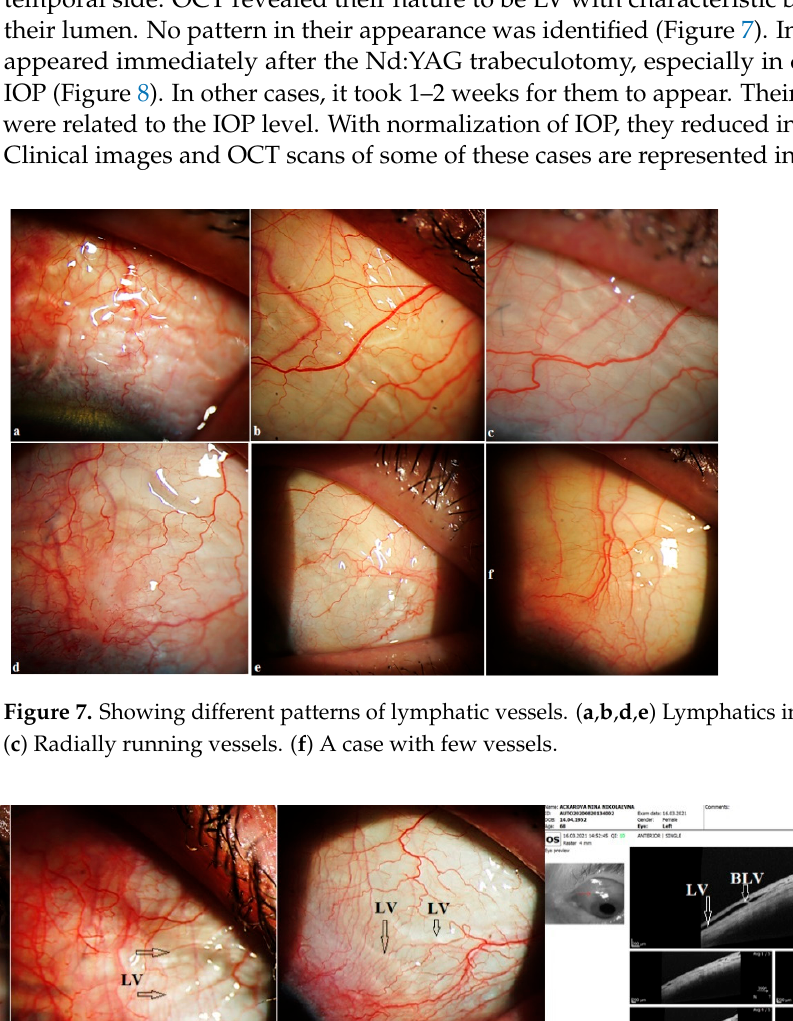
Figure 8. Development of lymphatic vessels immediately after the Nd:YAG laser trabeculotomy. ( a ) Showing conjunctiva medial to the surgery site immediately after trabeculotomy. Some irregular shaped swellings started appearing in the conjunctiva as aqueous humor began its exit from the anterior chamber. ( b ) Slit lamp view 15 min after trabeculotomy showing appearance of a plexus of LV. ( c ) Clinical image taken after a period of two weeks. The LV plexus is reduced in size and the IOP is below ten. ( d ) An OCT scan of the same area showing the presence of LV 1 week after the trabeculotomy. BLV = bicuspid lymphatic valves, LV = lymphatic vessels.